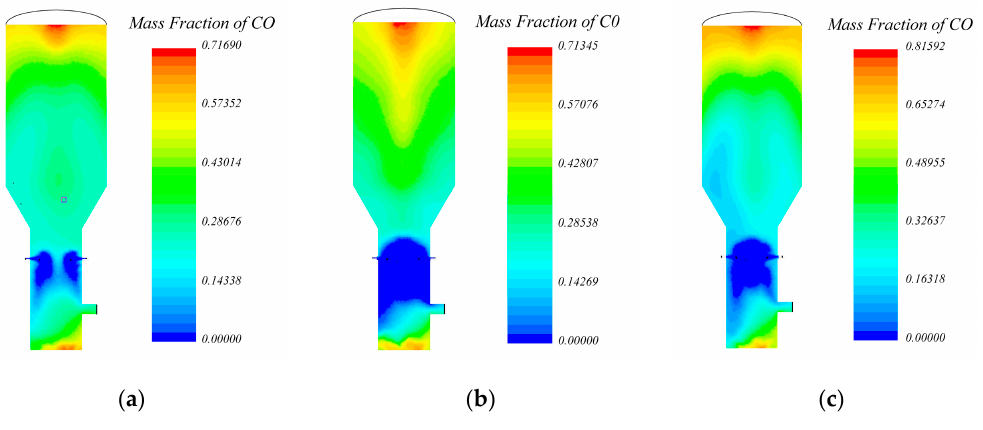
Figure A1. CO contours with ER values of ( a ) 0.2; ( b ) 0.35; ( c ) 0.5 from left to right.